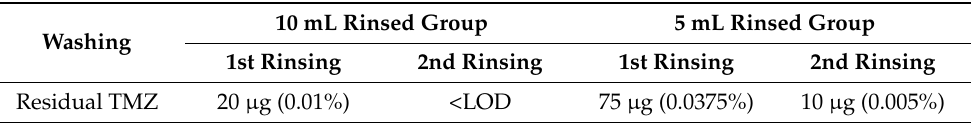
Table 3. Residual TMZ extracted from nasogastric tubes after administration of 200 mg TMZ. After the first or second rinse with 5 or 10 mL of water (following nasogastric tube supplier